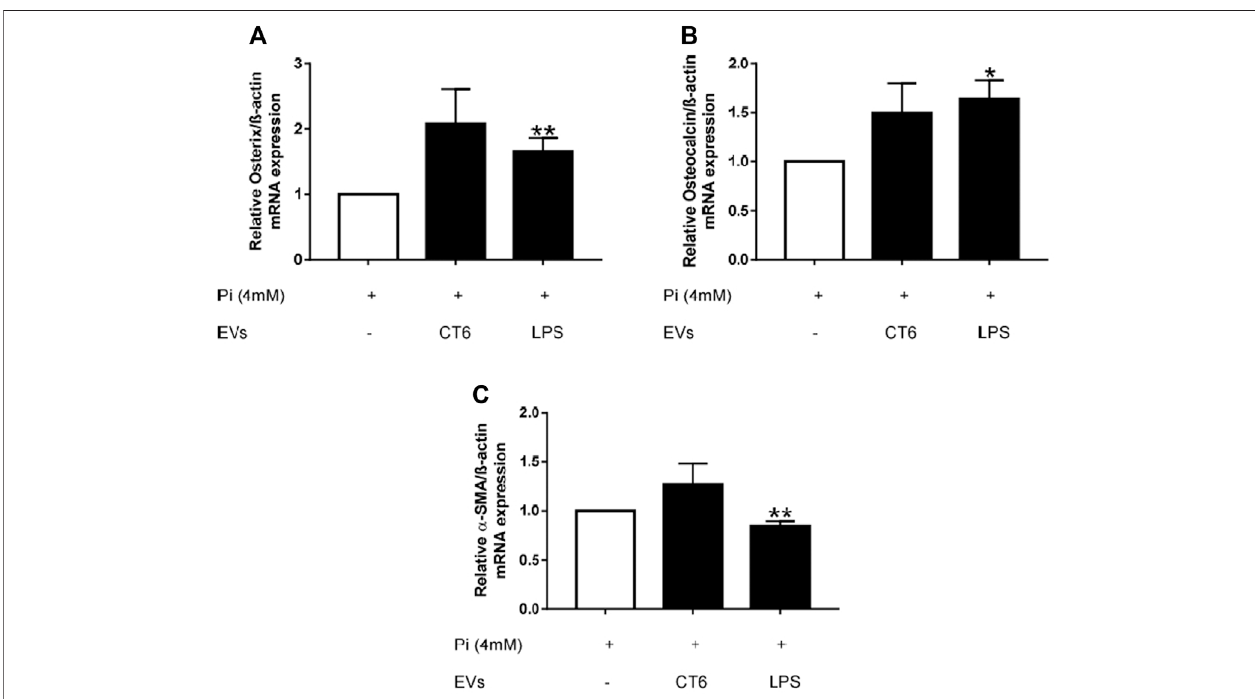
FIGURE14| EV-LPSincreaseosteogenicmarkergeneexpressionanddecreasecontractilemarkergeneexpressioninsmoothmusclecells.MOVAS-1cellswere incubated with 4 mM Pi, with or without RAW cell-derived EVs, for 7 days. Gene expression of (A) osterix, (B) osteocalcin, and (C) α -SMA was then quanti fi ed by quantitative real-time PCR and normalized to that of the housekeeping gene ß-actin. Data are expressed as the mean ± SEM of at least four independent experiments performed in triplicate ( n = 4). * p < 0.05 vs . 4 mM Pi, ** p < 0.01 vs . 4 mM Pi, Mann Whitney test. EV-CT: EVs derived from untreated macrophages, EV-LPS: EVs derived from LPS-EK-treated